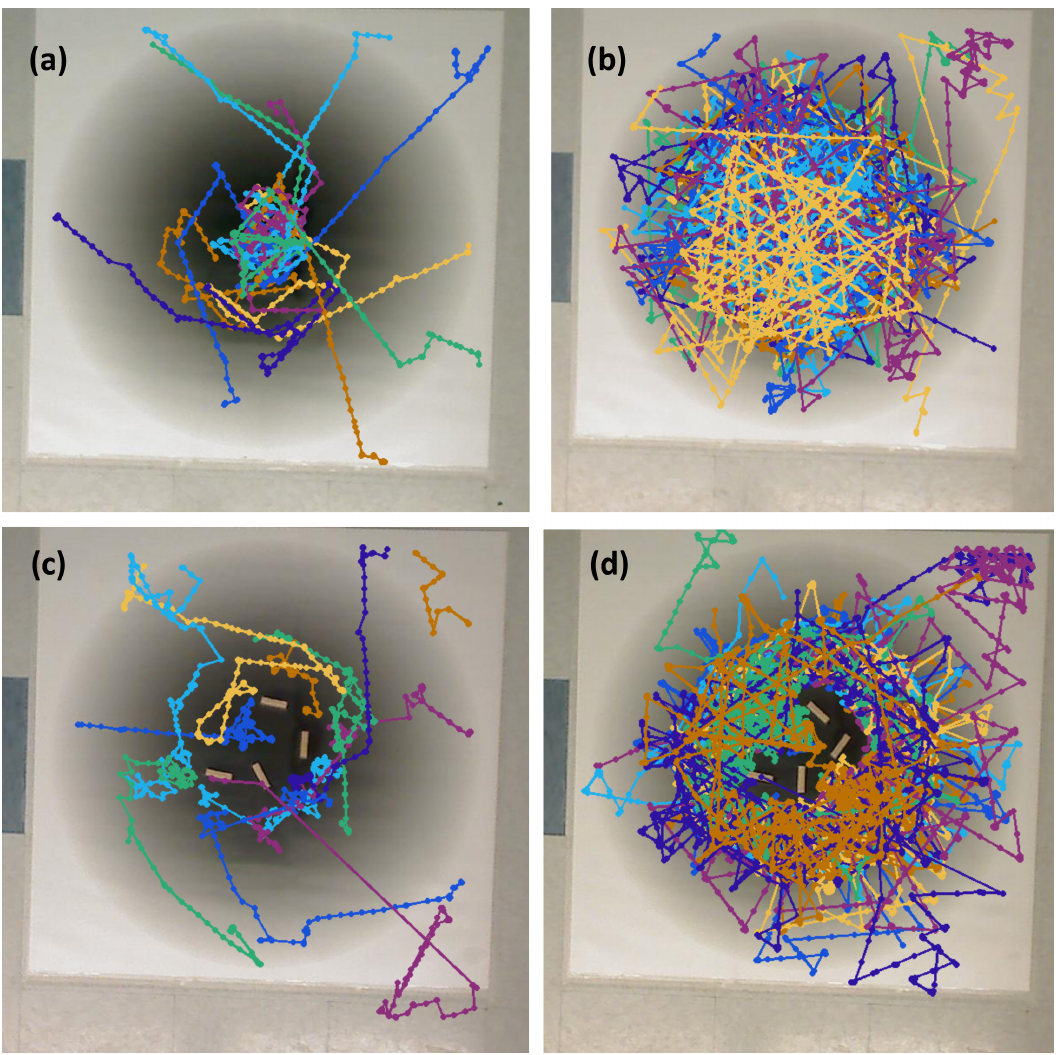
Figure 22. Summary of experimental runs with single effluent for all 12 initial positions that began on the area covered by the poster: ( a ) Basic controller, no obstacles; ( b ) RapidCell controller, no obstacles; ( c ) Basic controller, with obstacles; ( d ) RapidCell controller, with